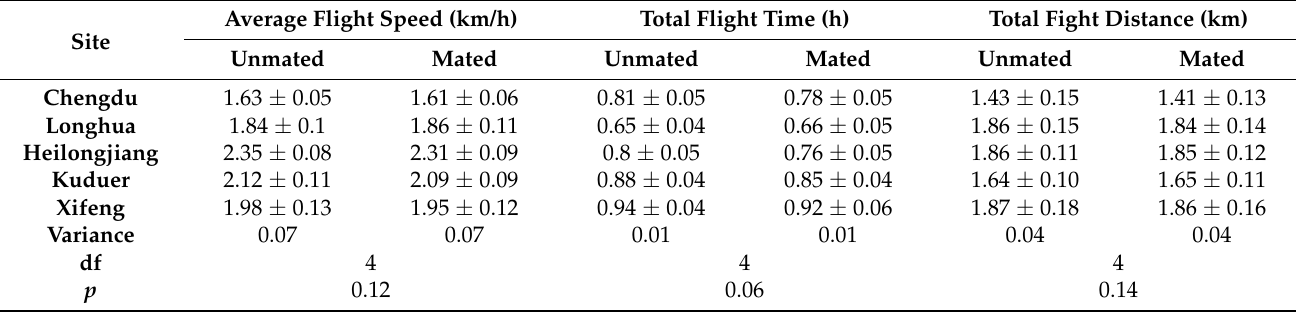
Table 5. Impact of mating status on the flight speed, duration and distance of female Asian spongy moth ( L. dispar asiatica ) populations from five different geographical locations in China. Values are presented as Mean ± SE.